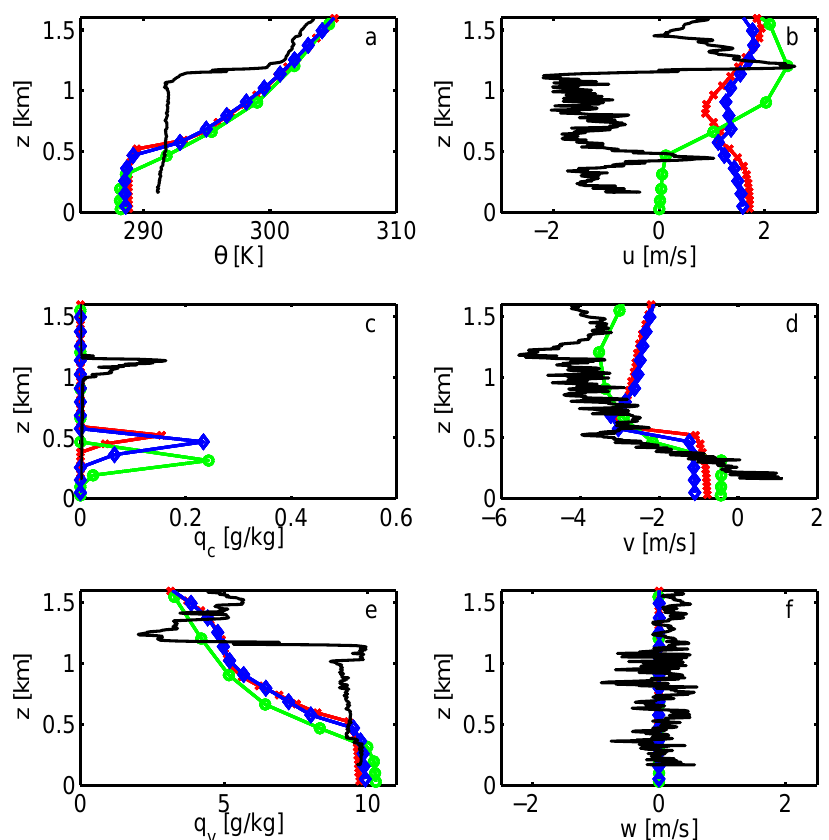
Fig. 2. Model sensitivity to the number of vertical levels for the profile 1; black line – observations, green – model run with 36 vertical levels, blue – model run with 81 vertical levels, red – model run with 121 vertical levels.